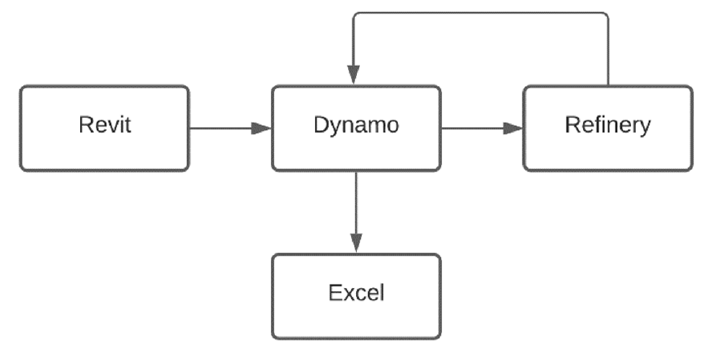
Figure 4. Scheme of interaction between the software. Source: the authors.